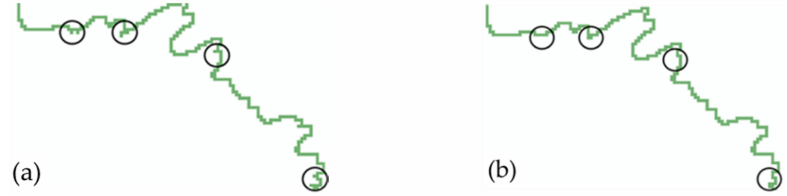
Figure 5. Contrast between before ( a ) and after ( b ) burr